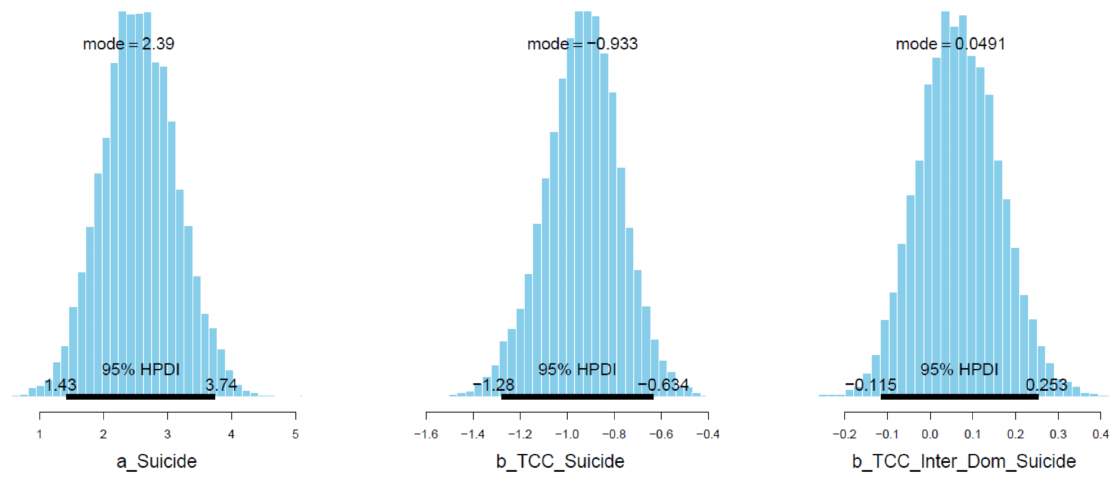
Figure 5. Distributions of Model 1 (cid:48) s posterior coefficients with HPDI at